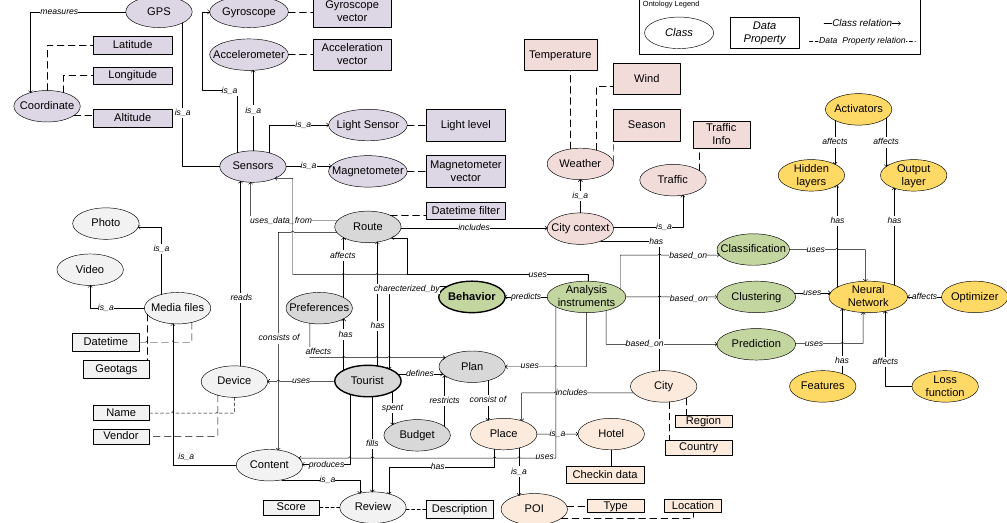
Figure 2. Enhanced digital pattern of life ontological representation with neural networks